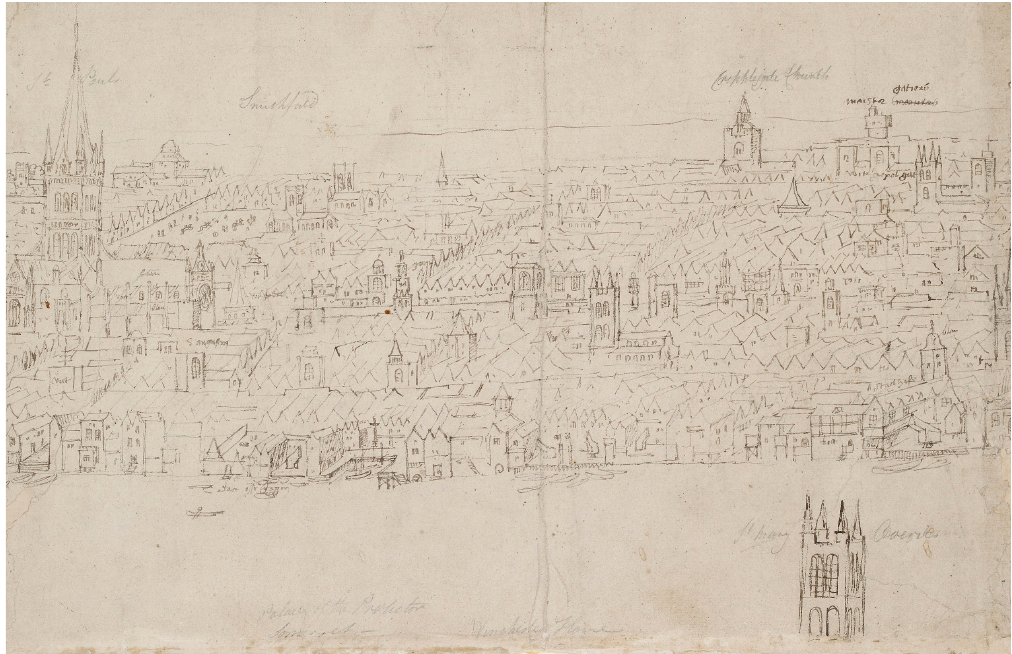
Fig. 3. Anthonis van den Wyngaerde, St. Paul’s Cathedral, part of the artist’s London Panorama, 1540s. Oxford, Ashmolean Museum [Accession Number: WA1950.206.5]. Drawing in pen and ink. Image © Ashmolean